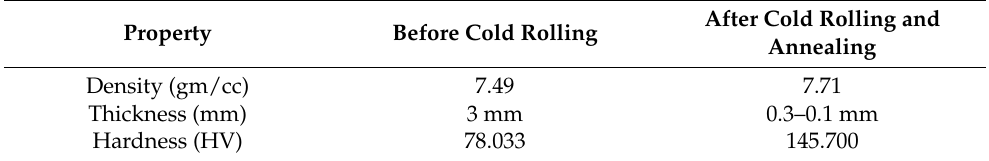
Table 4. Changes in physical properties of the cold rolled iron